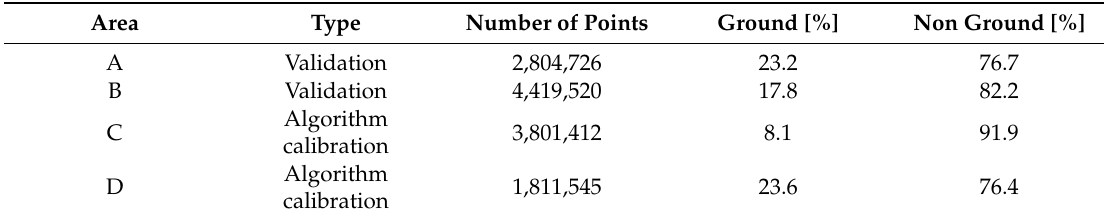
Table 1. Light detection and ranging (LiDAR) data used in the study.